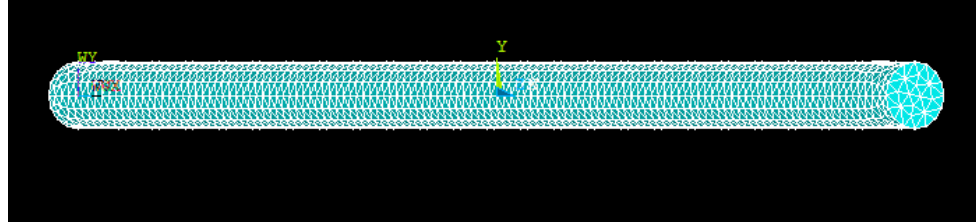
Figure 2. 3D cylinder constructed and meshed in ANSYS.